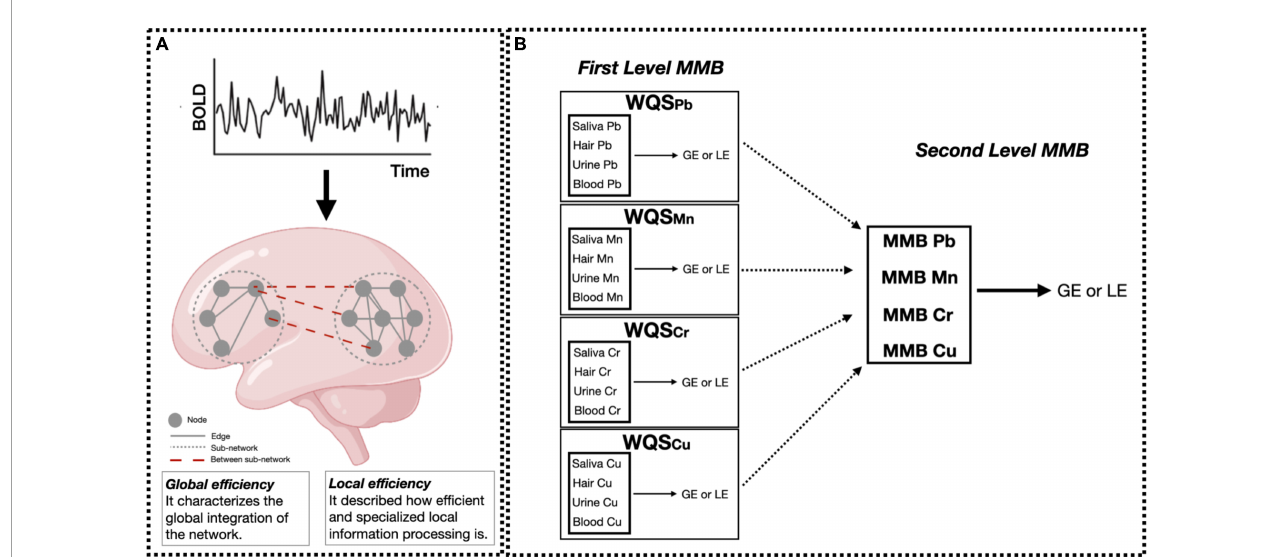
FIGURE1 Data analysis flowchart. (A) Resting-state fMRI data were preprocessed and the averaged time-series were extracted using the Harvard-Oxford atlas. Then, global and local efficiency (GE and LE, respectively) metrics were computed for each participant using graph theory. Small solid gray circles represent nodes of the graphs (brain regions), while gray connecting lines are the edges of the graph (functional connections). Larger dotted circles represent segregated sub-graphs/networks (functional network characterized by highly connected brain areas), while dashed red lines are the within-network connections at the whole brain level. Panel (B) shows the two hierarchical levels of analysis performed using the MMB WQS approach to measure the effect of Pb, Mn, Cr, Cu on brain metrics (GE and LE). At the first level, WQS was performed to measure and derive the MMB metric for each metal individually (Pb, Mn, Cr, Cu) on brain metrics (GE and LE). Then, the joint effect of Pb, Mn, Cr, Cu on brain metrics was assessed by applying WQS to Pb, Mn, Cr, and Cu MMBs. All models were adjusted for sex and age. Figure adapted from Levin-Schwartz et al. (2019) and Rakesh et al.